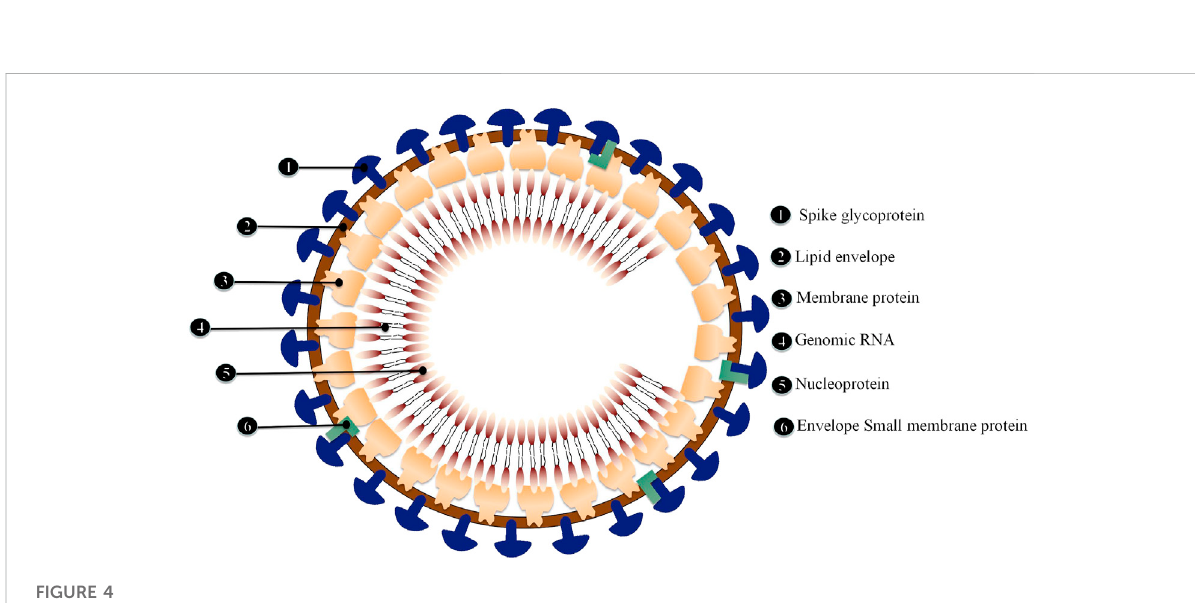
Schematic diagram of SARS-CoV-2